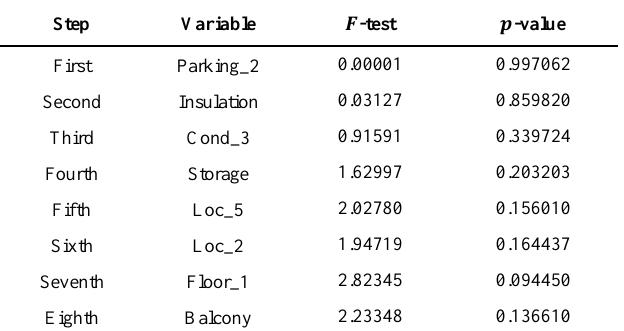
Table 5. 𝑭 -test values for eliminated variables.